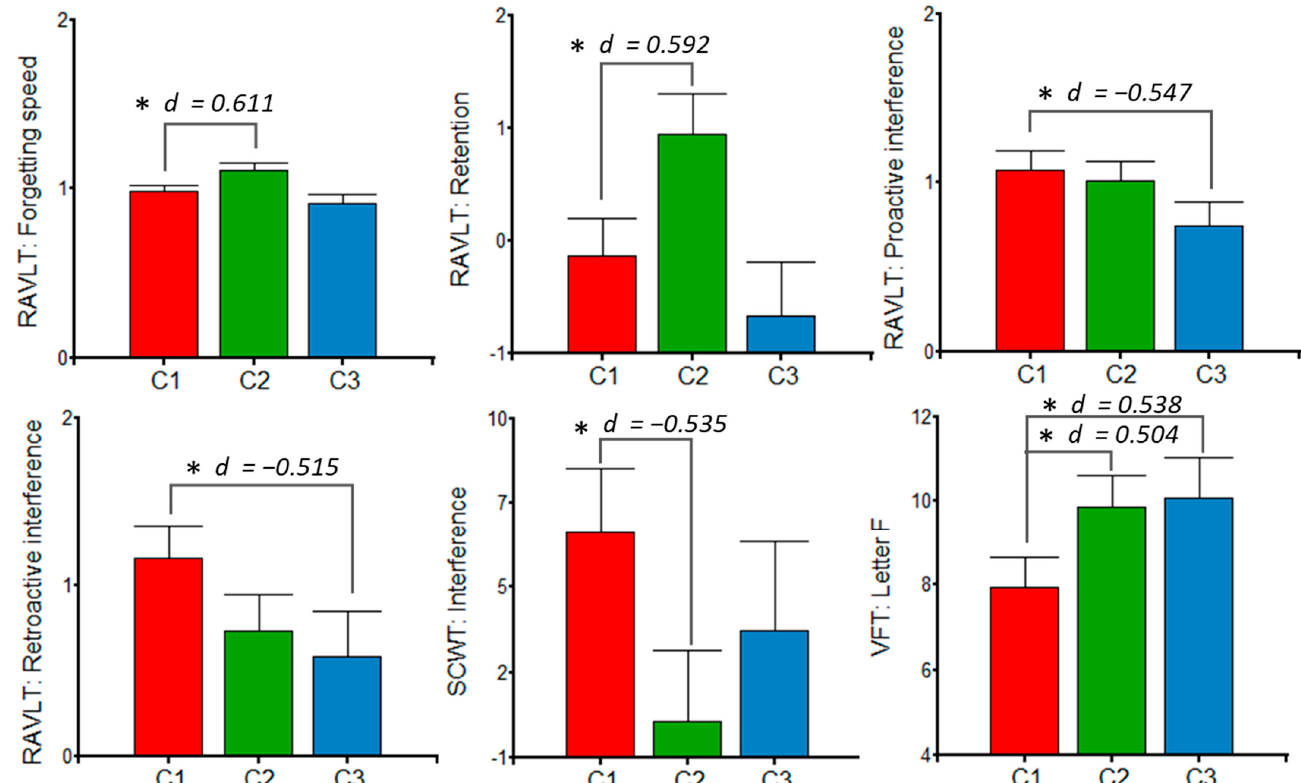
Figure 5. Postpartum women’s performance in the Rey Auditory Verbal Learning Test (RAVLT), Stroop Color and Word Test (SCWT), and Verbal Fluency Task (VFT) according to polyphenolic intake clusters (>20 mg/d). ANCOVA models were adjusted by educational level, postpartum days, parity, dietary indices (macronutritional, phytochemical and energetic), and insomnia, with a Fisher’s post hoc contrast. C1: n = 34; C2: n = 24; C3: n = 17. d = Cohen’s d for effect size; * p < 0.05.